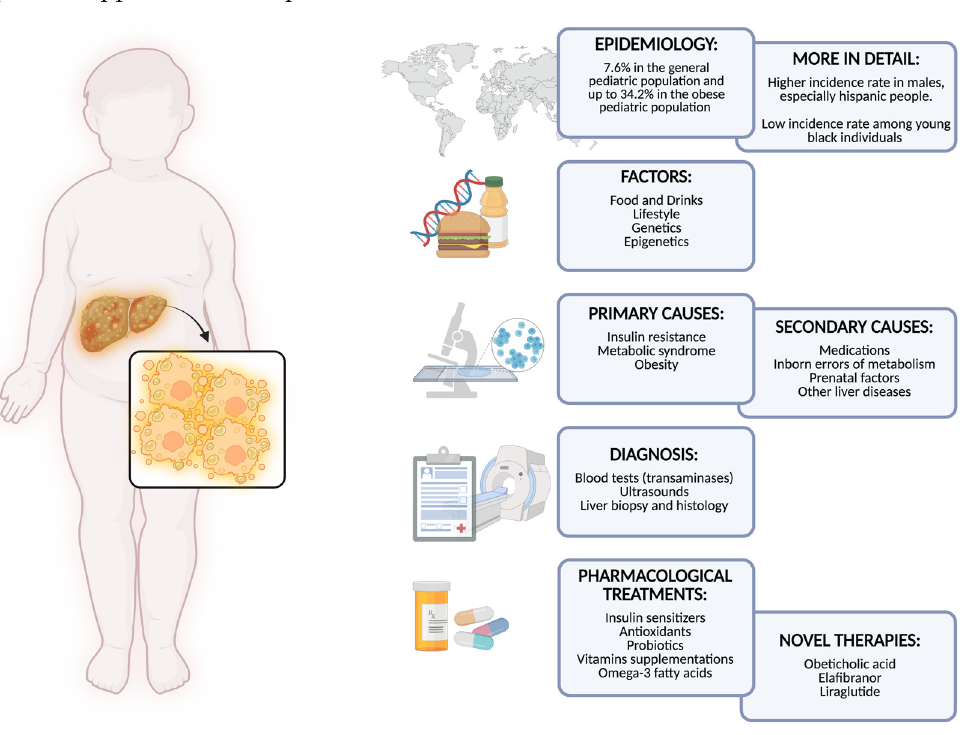
Figure 2. Nonalcoholic fatty liver disease in children and adolescents (created with BioRender.com, accessed on 1 July 2022).